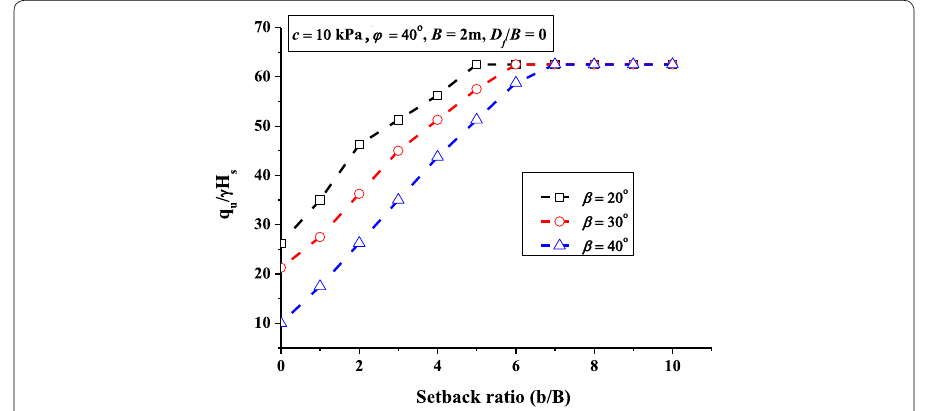
Fig. 10 Typical variation of q u / γH s with slope angle ( β ) and setback ratio ( b/B )